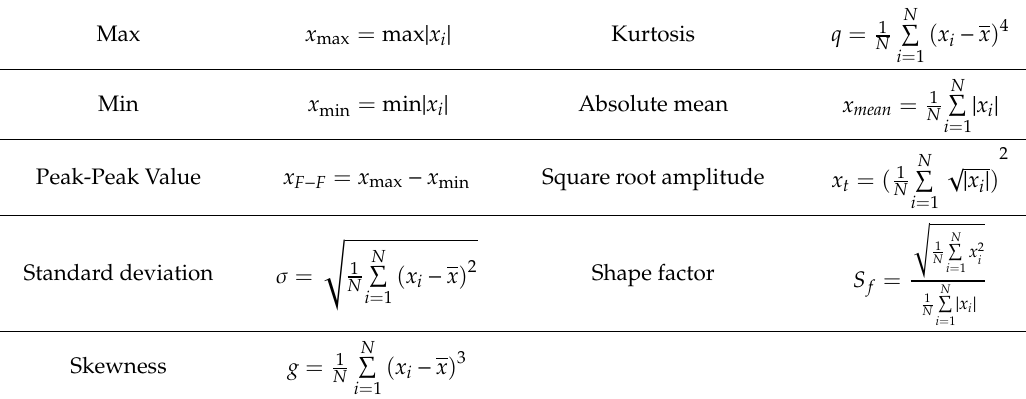
Table 3. Features selected in the time domain.